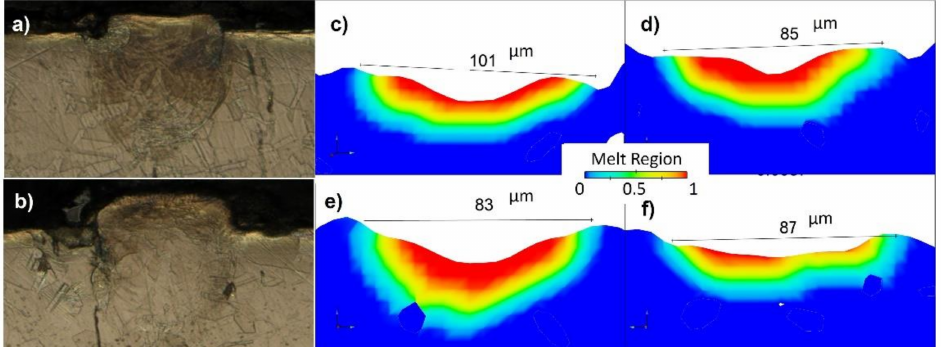
Figure 22. ( a , b ) OM at two different points of the P1S2 track. ( c – f ) The cross-sectional views of the same track at different